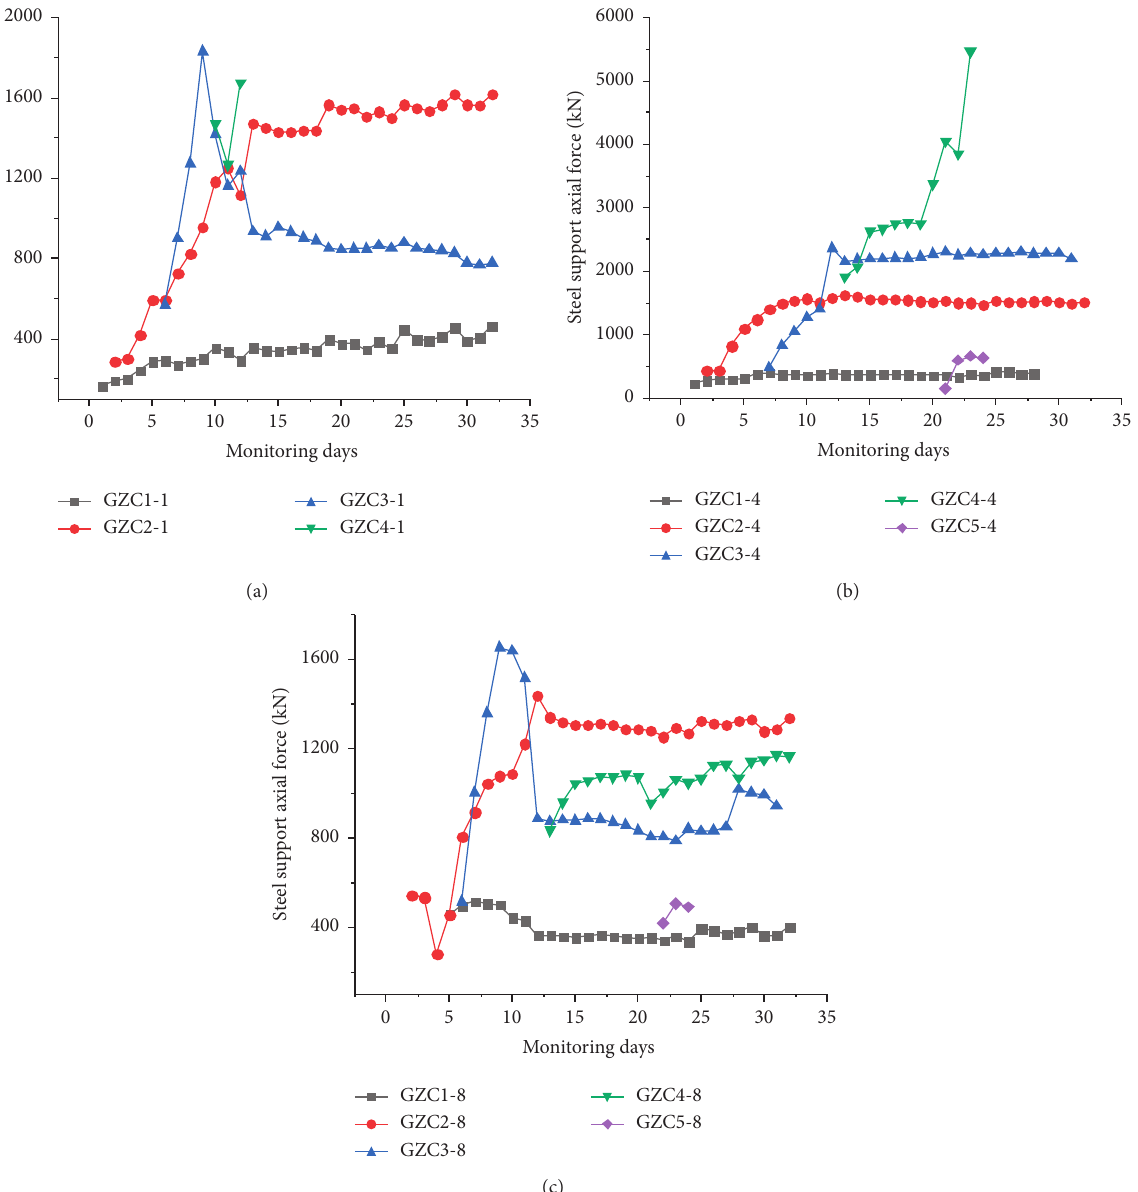
Figure 20: Axial force change curve of steel support. (a) Change of axial force of steel support at No. 1 section measuring point. (b) Axial force change of steel support at No. 4 section measurement point. (c) Change of axial force of steel support at No. 8 section measuring